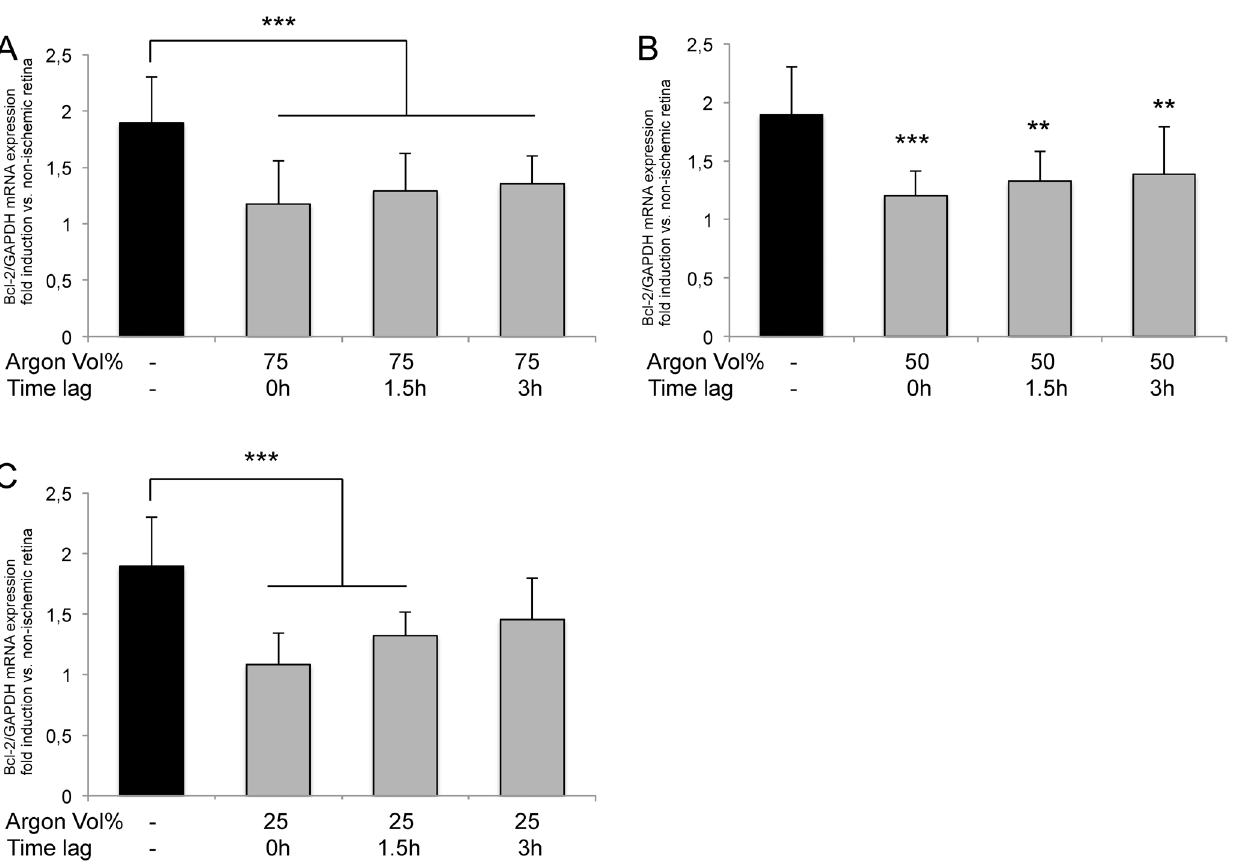
Fig. 5. Effect of Argon inhalation on retinal expression of Bcl-2 mRNA. Fold induction of Bcl-2 mRNA expression in ischemic retinal tissue compared to GAPDH in relation to the corresponding non-ischemic retinae analyzed by RT-PCR after ( A ) 75 Vol% Argon inhalation (*** 5 p , 0.001 IRI vs. IRI + Argon at all time points), ( B ) 50 Vol% Argon inhalation (*** 5 p , 0.001 IRI vs. IRI + Argon immediate treatment, ** 5 p , 0.01 IRI vs. IRI + Argon at 1.5 h and 3 h delayed treatment) and ( C ) 25 Vol% Argon inhalation (*** 5 p , 0.001 IRI vs. IRI + Argon immediately and at 1.5 h delayed treatment). All n 5 8; data are mean ¡